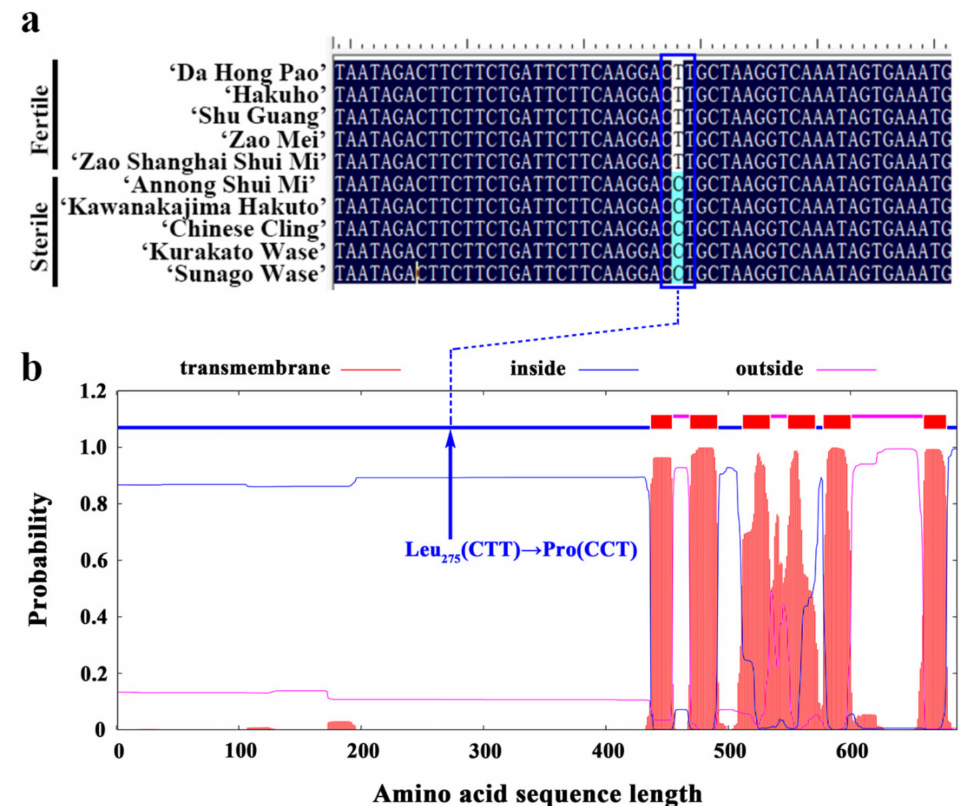
Figure 6. Sequence analysis of the candidate gene PpABCG26 . ( a ) The sequence alignment of PpABCG26 in the five fertile and five sterile peach cultivars. The blue box indicates the nonsynonymous SNP (T/C) at +824 bp in the coding region. ( b ) The predicted transmembrane helices of PpABCG26. The blue arrow indicates the resultant amino acid change from Leu 275 (CTT) to Pro